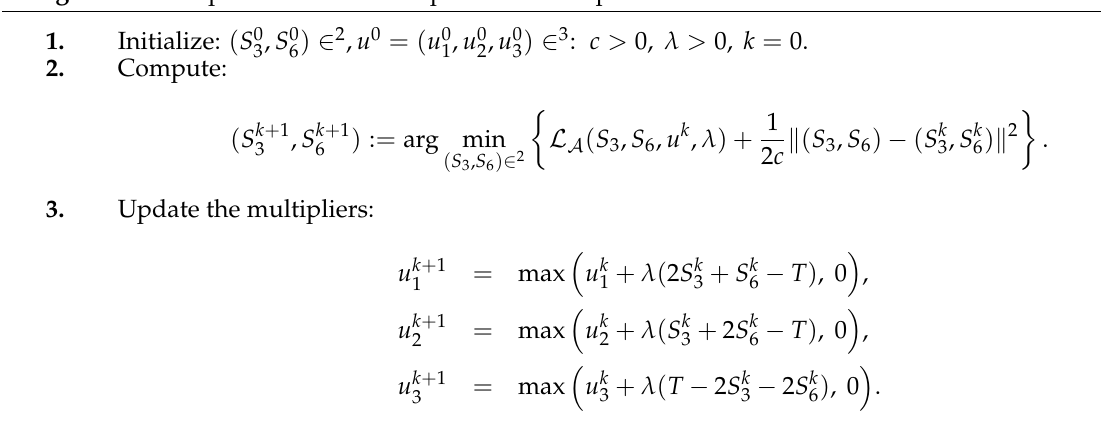
Algorithm 1: Implementation of the proximal multipliers